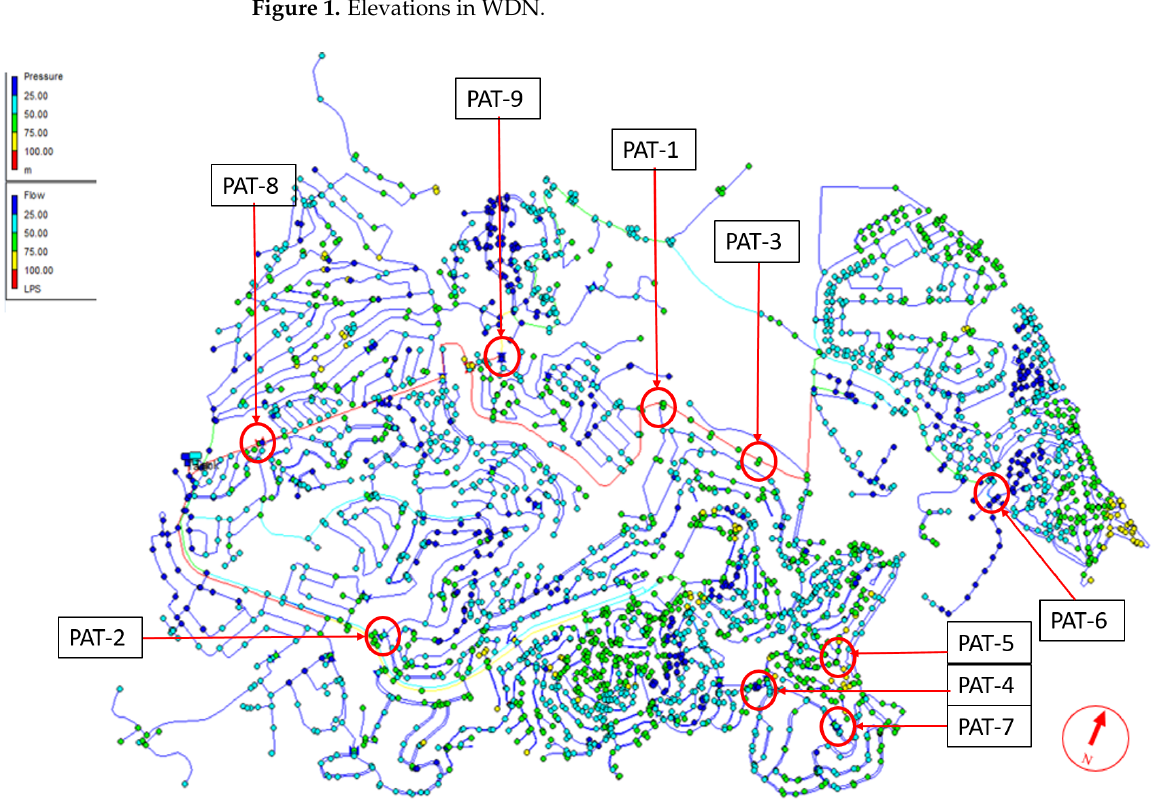
Figure 2. WDN showing proposed PAT locations and flow rate in pipes and pressure head at the